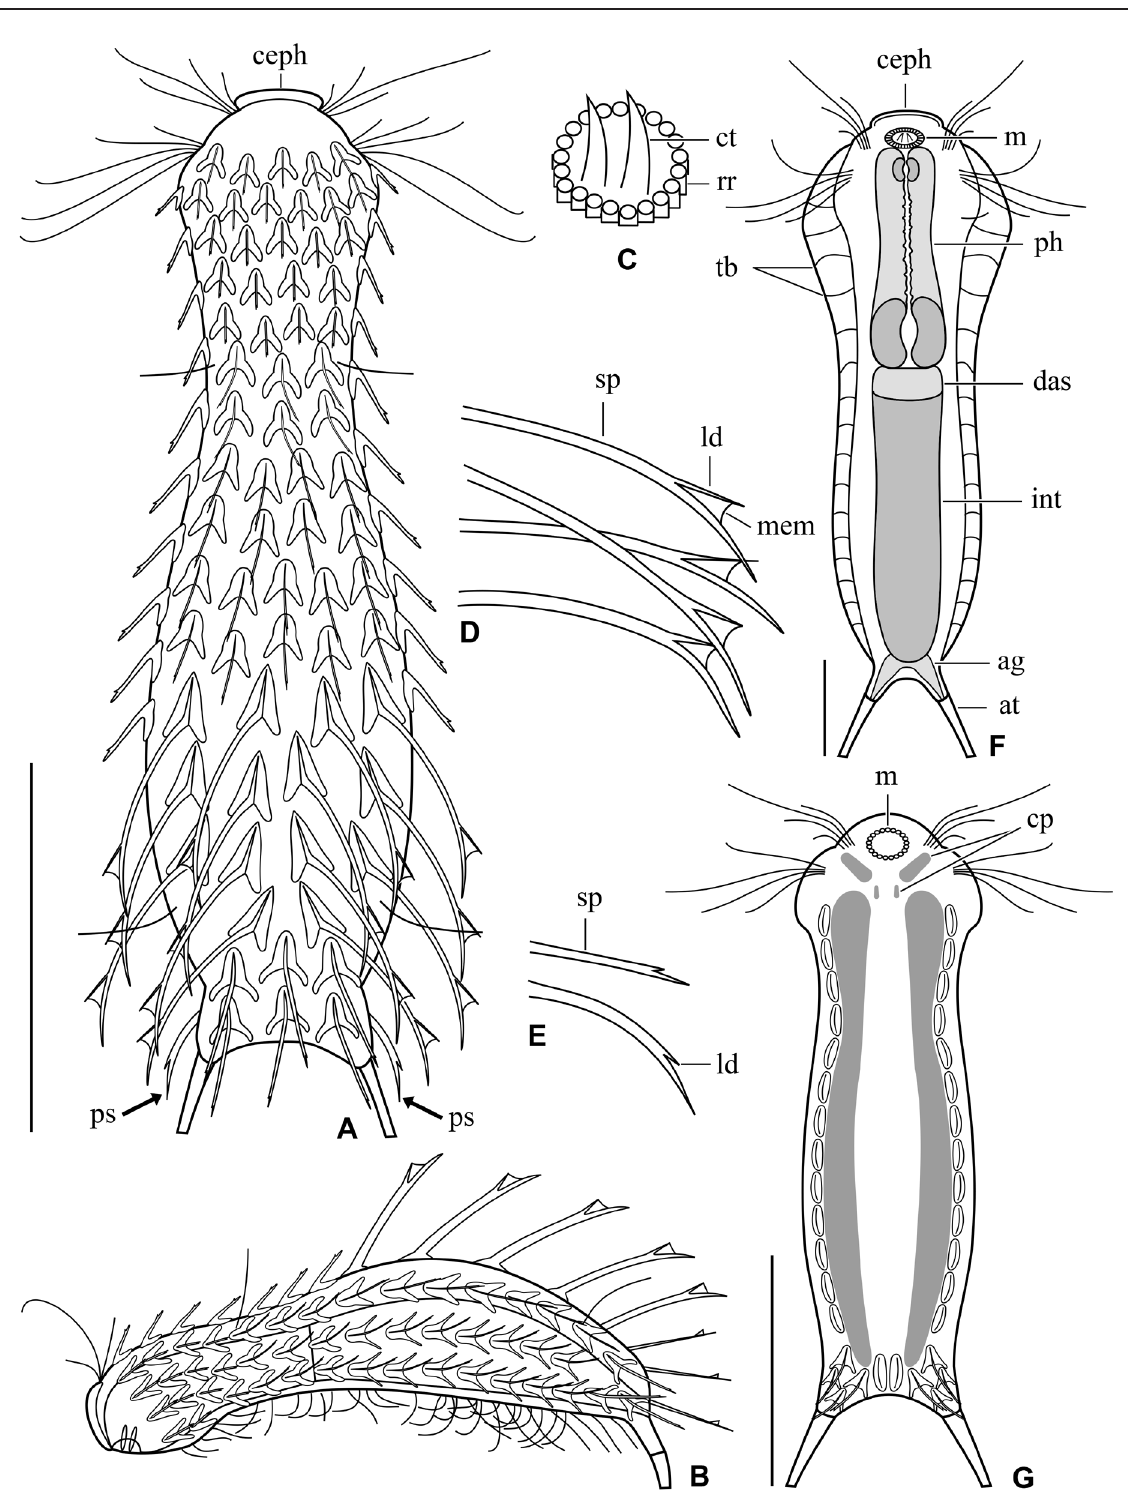
Fig. 10. Chaetonotus ( Hystricochaetonotus ) mirabilis sp. nov. A‒B . Dorsal and lateral overviews showing the scale and spine pattern. C . Detail showing the cuticular teeth protruding from the mouth ring. D . Elongated dorsal spines with a membrane. E . Terminal dorsal spines. F . Internal morphology of a strongly squeezed specimen (body shape hence not representative). G . Ventral overview. Scale bars: A = 30 µm; F–G = 20